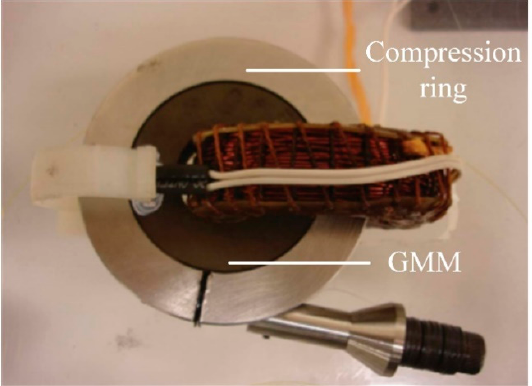
Figure 8. Optical fiber current sensor based on 144 g annular solid magnetostrictive material.